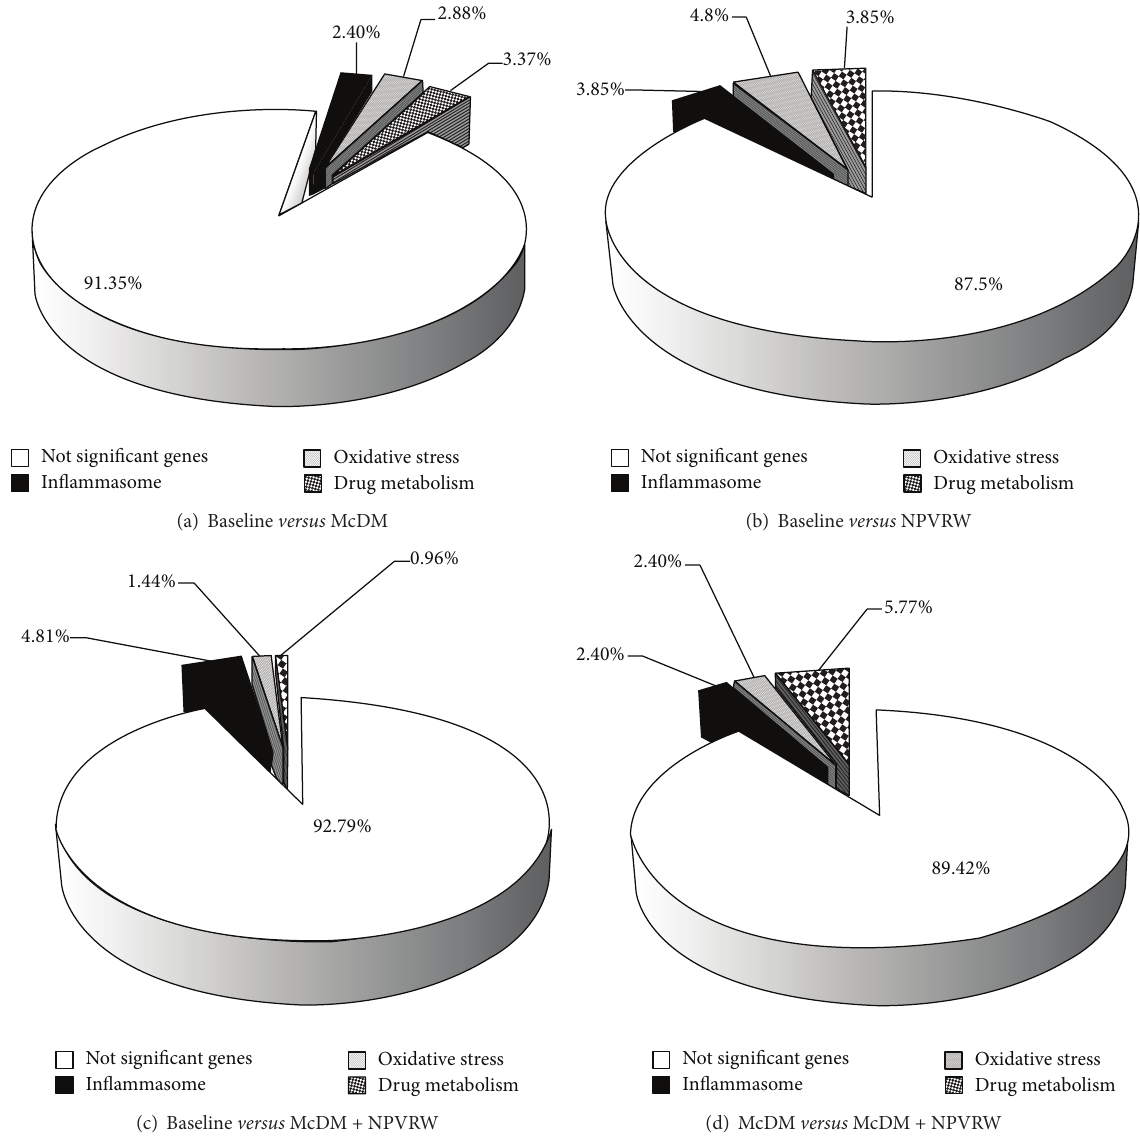
Figure 3: Expression of genomic pathways. Percentage of significant genes in comparison between: (a) baseline versus McDonald’s meal; (b) baseline versus NPVRW; (c) baseline versus McDonald’s meal + not pruned vineyard red wine; (d) McDonald’s meal versus McDonald’s meal + not pruned vineyard red